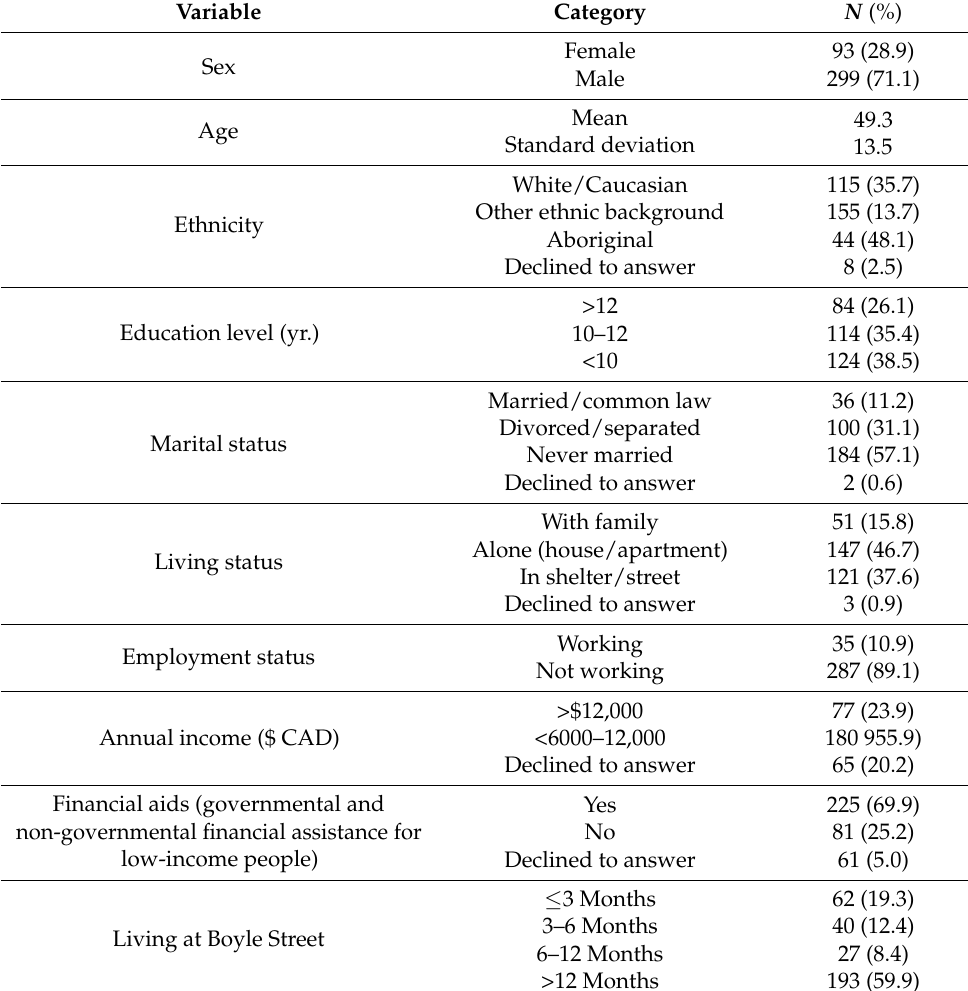
Table 1. Demographic characteristics ( N = 322).